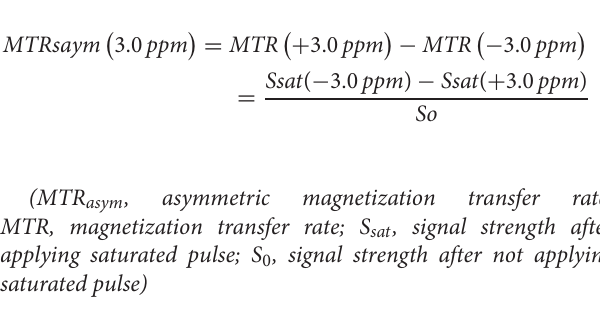
MTRsaym (cid:0) 3.0 ppm (cid:1) = MTR (cid:0) + 3.0 ppm (cid:1) − MTR (cid:0) − 3.0 ppm